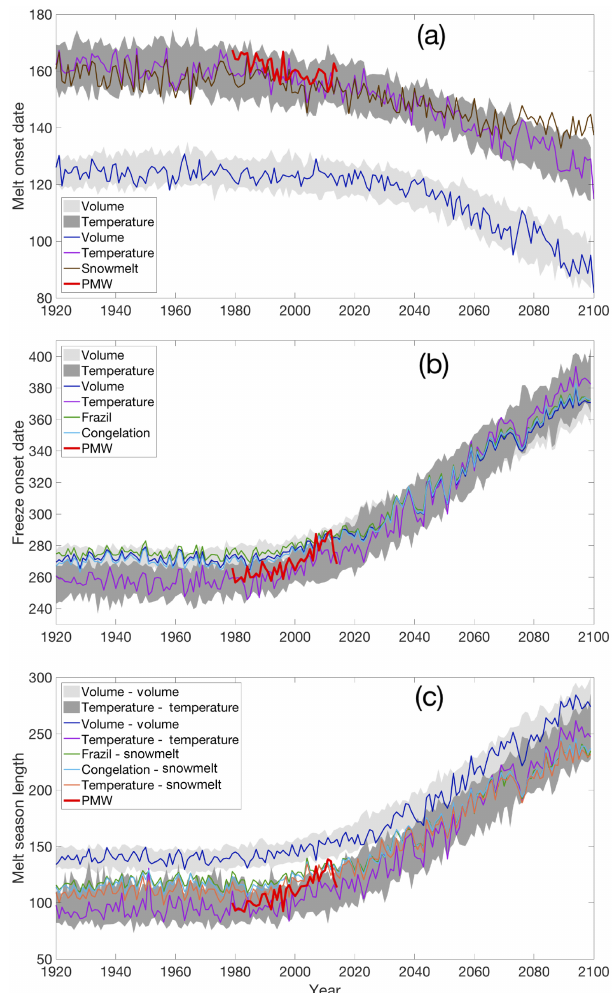
Figure 1. Melt season characteristics averaged over 66 to 84.5 ◦ N for PMW satellite observations and each CESM LE definition for (a) melt onset, (b) freeze onset and (c) melt season length. PMW satellite observations are shown in red. Other colored lines represent ensemble member 35, and the gray shading represents the ensemble spread for the two definitions (surface temperature and thermody- namic ice volume tendency) that have 40 ensemble members. Plots are reproduced with member 34 in colored lines in Fig.